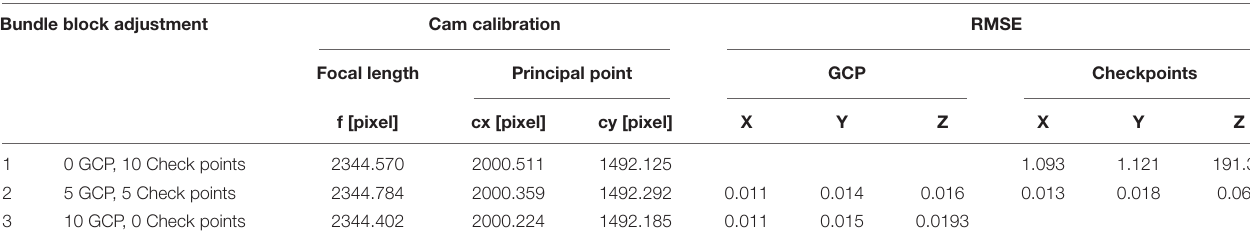
TABLE 4 | Drone photogrammetry results of triangulation and camera